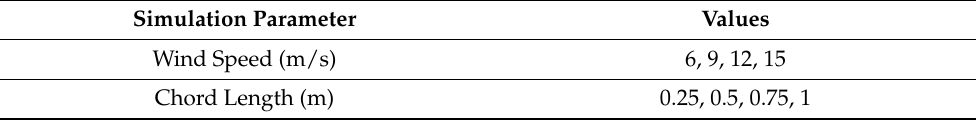
Table 2. Wind speed and chord lengths